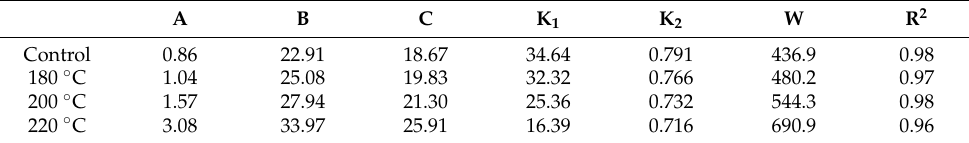
Table 2. Fitting coefficients for the Hailwood–Horrobin isotherms adsorption.